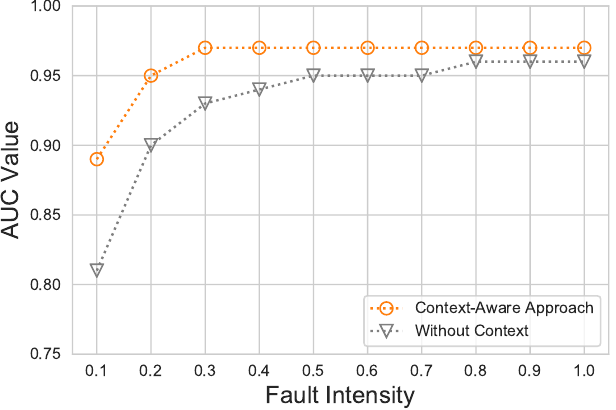
Figure 9. ROC-AUC against diverse fault intensities of the proposed ET-based context-aware ap- proach, compared to the without-context approach.